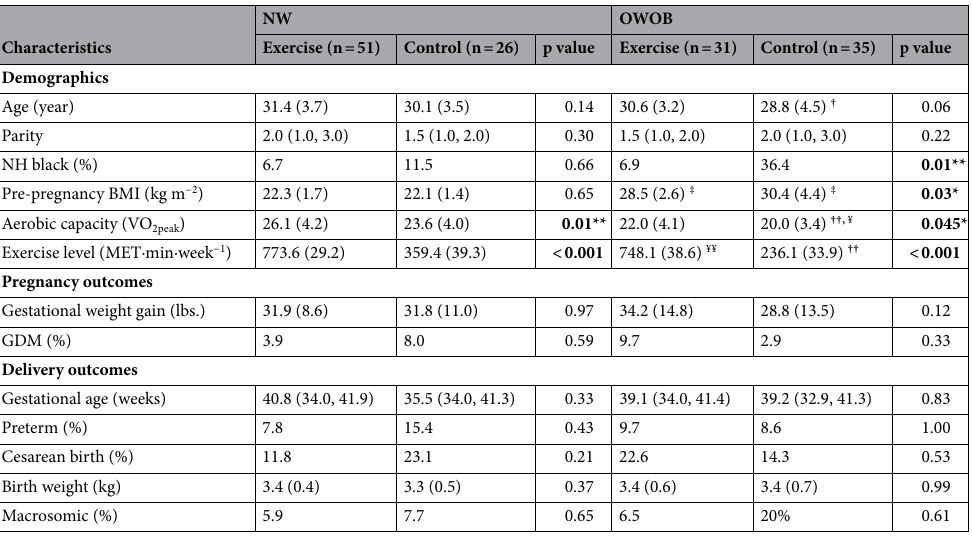
Table 3. Per Protocol analysis of Maternal Descriptive, Pregnancy and Delivery Outcomes by Intervention and BMI Group. Means (SD), medians (range) and proportions are reported and Student’s t-test, Wilcoxon Rank Sum tests and Fisher’s Exact tests were performed, respectively. NH non-Hispanic, BMI body mass index, GDM gestational diabetes mellitus. Within BMI class comparison *p < 0.05, **p < 0.01, p < 0.001; † p = 0.01 relative to NW Exercise group; † p < 0.001 relative to NW Exercise group. ‡ p < 0.001 within BMI and between NW BMI groups; ¥ p < 0.01 relative to NW Control group; ¥¥ p < 0.001 relative to NW Control group. Significant values are in [bold].